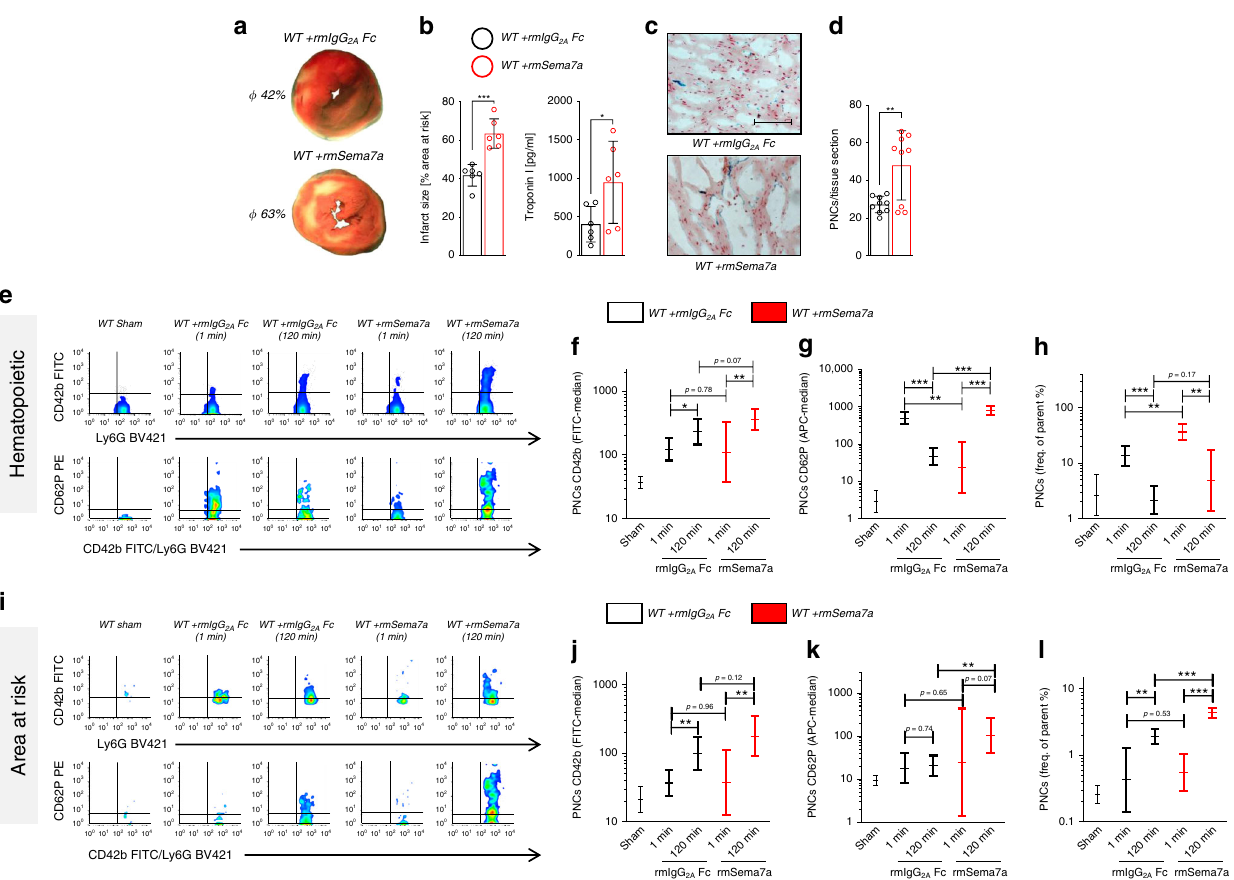
Fig. 2 Injection of Sema7a results in increased MIRI and PNC formation. Mice were injected with either recombinant semaphorin 7a (rmSema7a) or Fc control (rmIgG 2A Fc) and then subjected to 1 h of ischemia followed by 2 h reperfusion. Samples were taken after 1 or 120 min reperfusion. a Representative TTC-stained slices of myocardial tissue showing infarcted area (blue/dark = retrograde Evans blue staining; red and white = AAR, white = infarcted tissue; 120 min) with b systematic evaluation of infarct sizes and corresponding troponin I plasma levels (120 min, n = 6/group). c Representative histological sections (scale bar 100 µ m) of WT animals injected with either IgG Fc control or rmSema7a (120 min) and d number of PNCs counted in myocardial tissue sections of AAR in animals (120 min, n = 9/group). e Representative fl ow-cytometric plots of PNCs in the blood of sham animals, rmSema7a- or IgG Fc control – treated mice, showing GPIb (CD42b) and P-selectin (CD62P) after 1 and 120 min reperfusion. Systematic evaluation of fl ow-cytometric expression of mean fl uorescence intensity (MFI) for f GPIb (CD42b, n = 6;6;4;4;6) and g P-selectin (CD62P, n = 6;3;5;3;7) expression. h Systematic evaluation of PNCs in % by fl ow cytometry in the blood of animals injected with rmSema7a or Fc control at 1 and 120 min ( n = 6;4;4;4;5). i Representative fl ow- cytometric plots of PNCs in the AAR showing the presence of GPIb (CD42b) and P-selectin (CD62P) after 1 and 120 min reperfusion. Systematic evaluation of fl ow-cytometric expression of MFI for j GPIb (CD42b, n = 5;5;5;4;6) and k P-selectin (CD62P, n = 6;4;5;3;5) and l systematic evaluation of PNCs in % by fl ow cytometry in the AAR of animals injected with rmSema7a or Fc control at 1 and 120 min ( n = 5;4;5;5;5). Comparisons in b and d were analyzed by unpaired two-tailed Student ’ s t -tests (data are mean ± SD). For f – h , j – l we used log transformation of data to conform normality. For log- transformed data, unpaired two-tailed Student ’ s t -tests were performed on the log values and results are displayed as geometric means and their 95% con fi dence intervals. * p < 0.05, ** p < 0.01, and *** p < 0.001 as